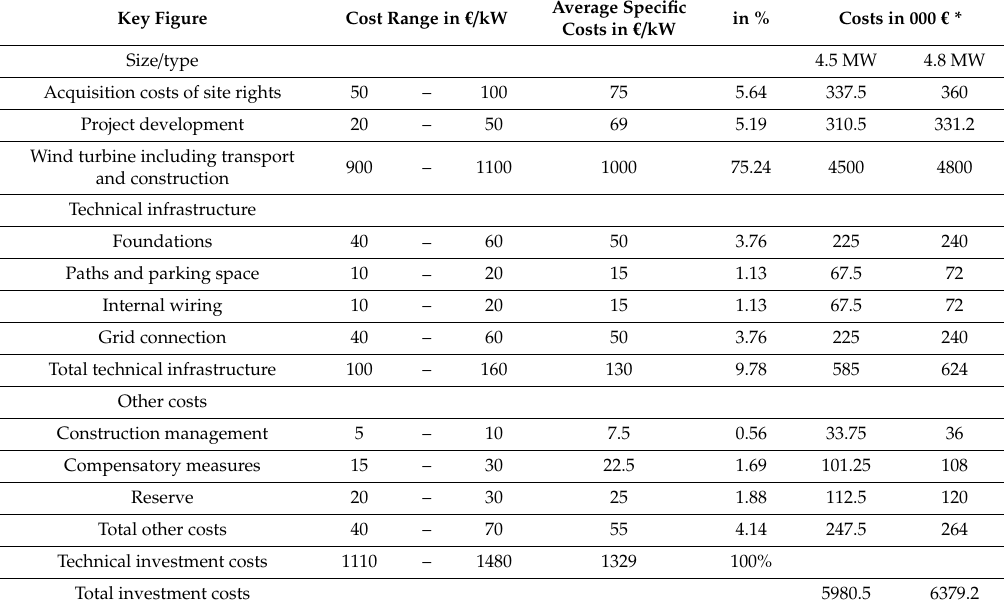
Table 2. Exemplary representation of the investment costs for the new wind turbines with connection to the high-voltage